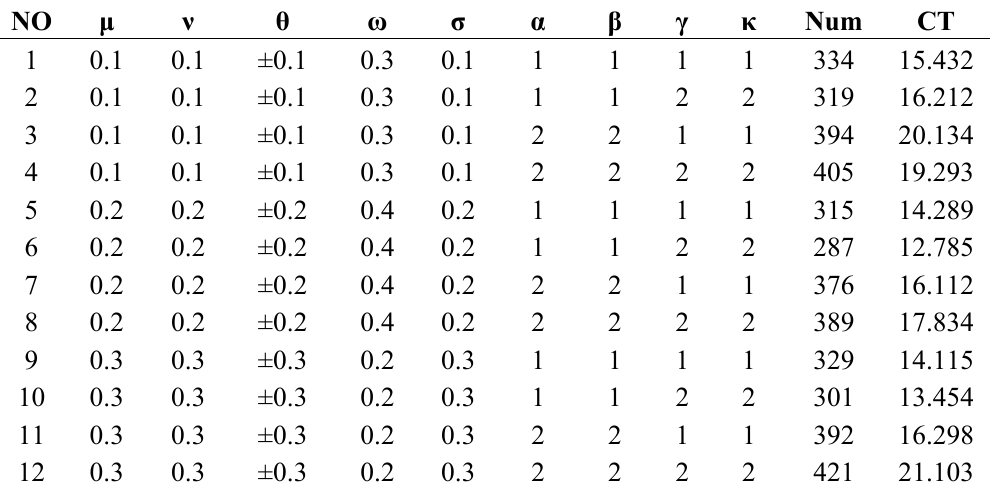
Table 1. Number of iterations and convergence time with diverse